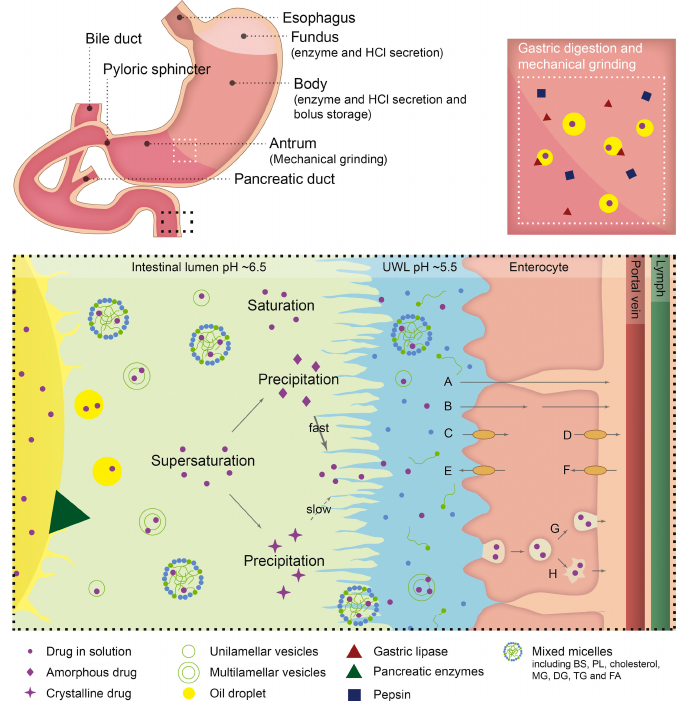
Figure 1. Schematic presentation of lipid digestion, drug solubilization, and absorption processes occurring in the stomach and small intestine. The stomach, the duodenum, and the initial part of the small intestine are illustrated in the top left corner with a zoom into the lower part of the stomach and the intestinal lumen, to the right and below, respectively. Transport pathways across the epithelial layer: paracellular passive diffusion (A), transcellular passive diffusion (B), influx/efflux facilitated transport by membrane proteins (C–F), transcytosis (G), and endocytosis (H). Abbreviations: bile salt (BS), phospholipids (PL), monoglycerides (MG), diglycerides (DG), triglycerides (TG), fatty acids (FA), and unstirred water layer (UWL). Components are not drawn to scale. Reprinted from [25] with permission (Elsevier 2019).